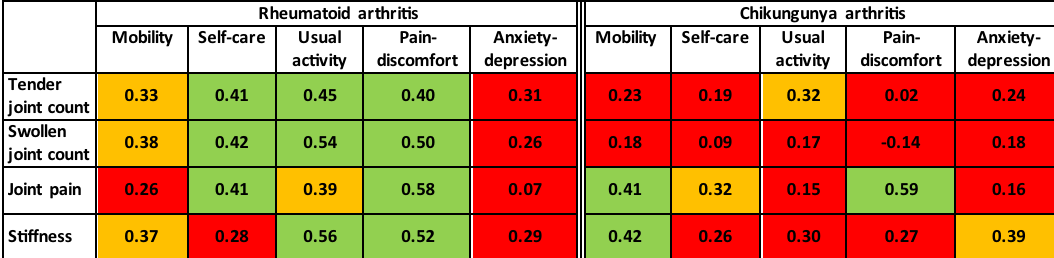
Figure 2. Association of disease severity with EQ5D quality of life domains in rheumatoid and chikungunya arthritis. Spearman’s Rank Correlation coefficient: red indicates not significant, orange indicates p < 0.05 and green indicates p <